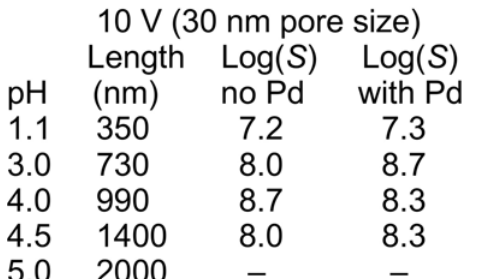
at room temperature. The 2